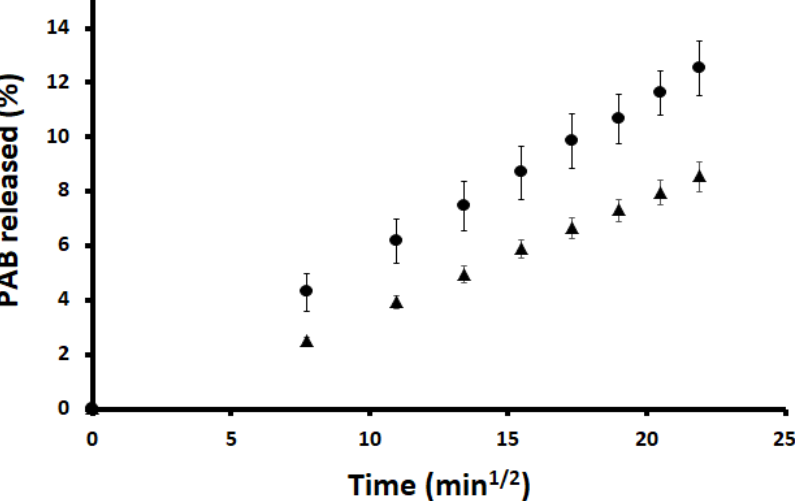
Figure 3. PAB release profiles: ( • ), PEG-GMO10 formulation; ( ▲ ), PEG-GMO20 formulation. Each point is the mean ± S.E. of three experiments.